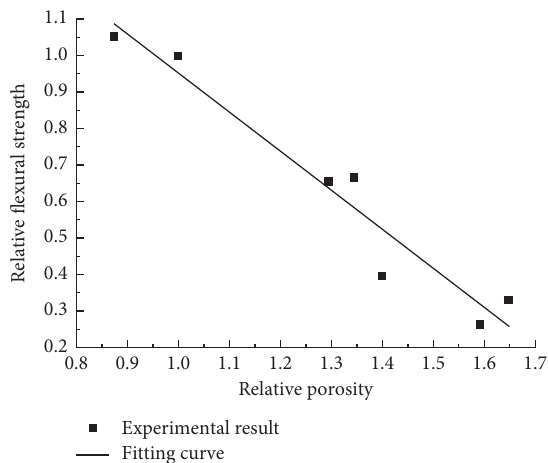
Figure 29: Relation between relative flexural strength and relative